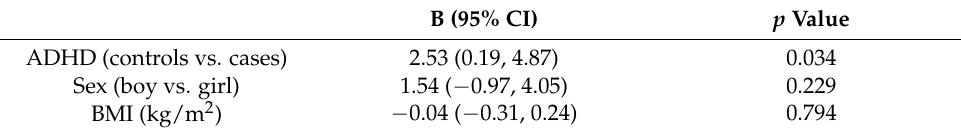
Table 3. The effect of ADHD status on DEFA1 levels examined using linear regression model, controlling for the potential confounding effects of sex and